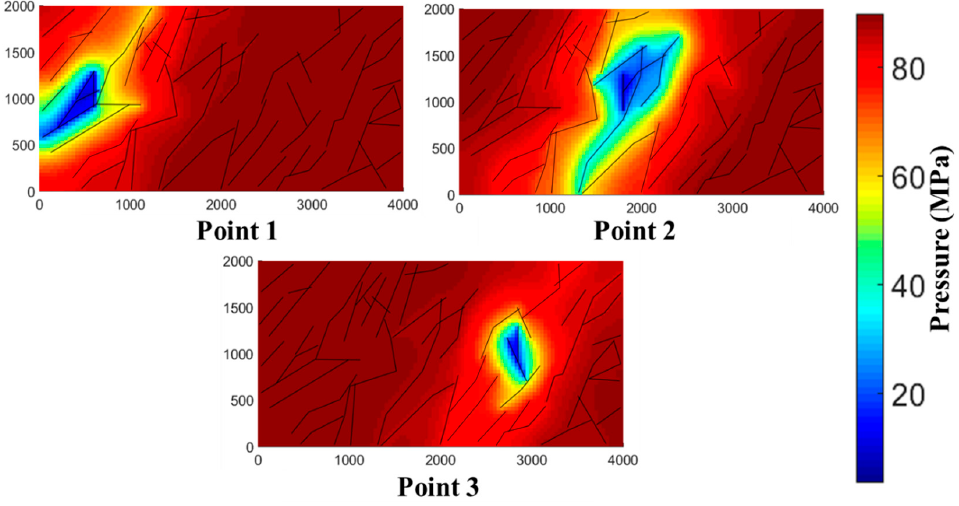
Figure 9. Schematic diagrams of pressure-drop-vulnerability distribution for different well locations. The comparison diagram of cumulative gas production under different well locations was obtained by numerical seepage simulation, as shown in Figure 10.